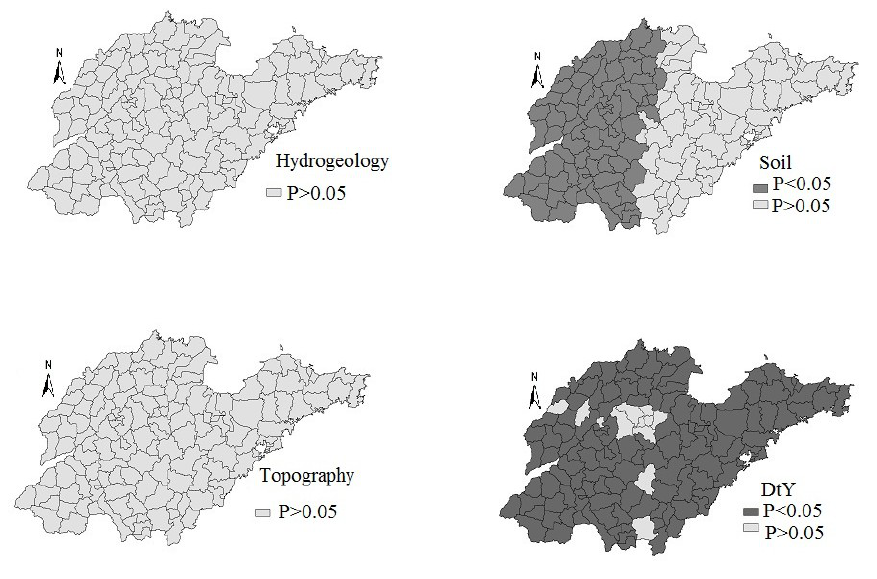
Figure 6. The p values of risk factors in geographically weighted